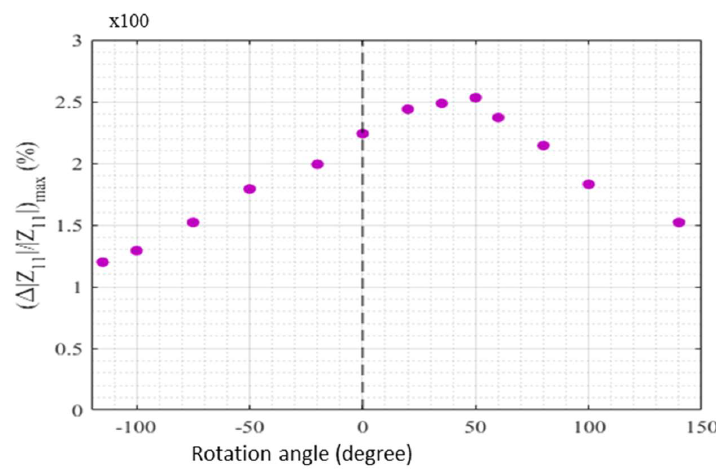
Figure 5. Maximum of the GMI ratio as a function of the rotation angle.